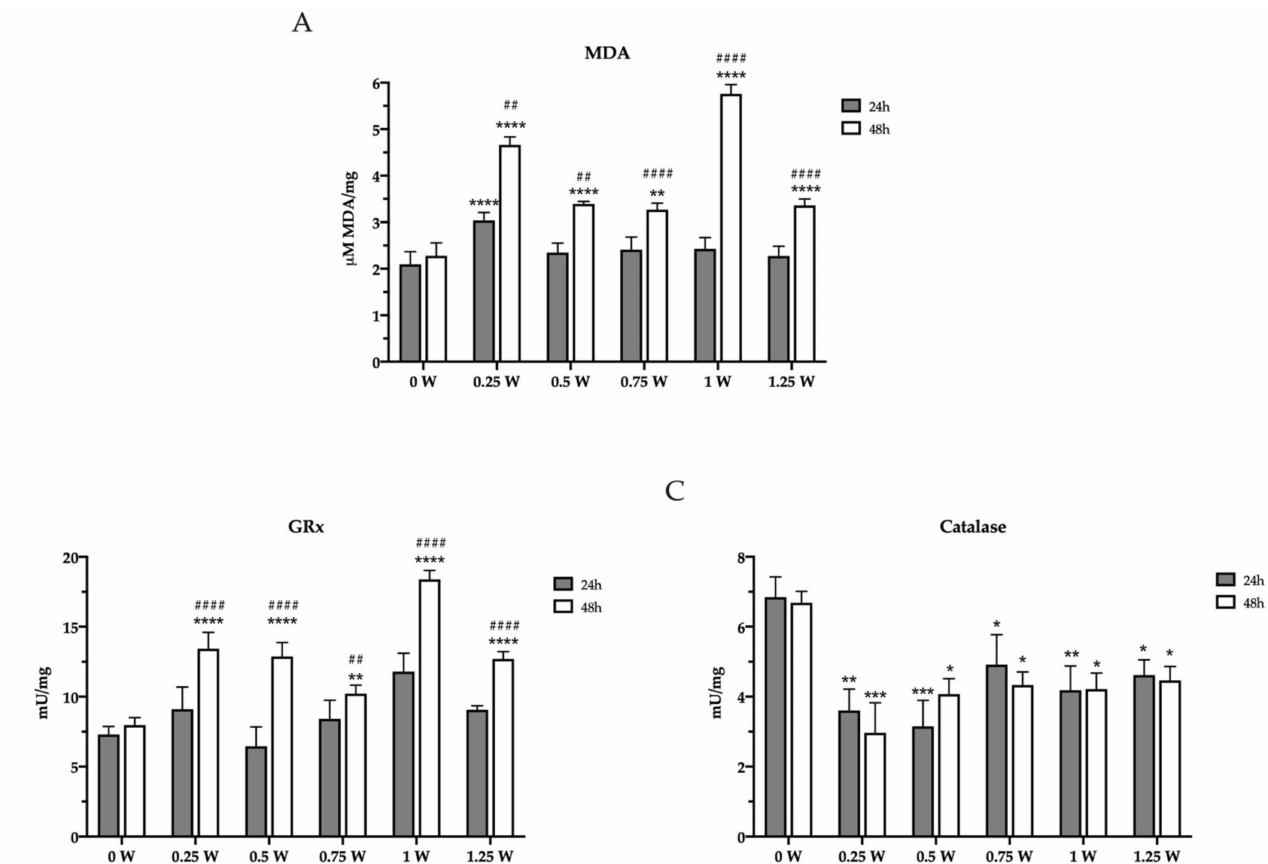
Figure 4. Lipid peroxidation and modulation of enzymatic antioxidant defenses in OHSU-974 FAcorr cells after 808-nm laser irradiation. ( A ) Malondialdheyde (MDA) level. ( B ) Glutathione reductase (GRx) activity. ( C ) Catalase activity. In each graph, grey and white columns represent the data obtained 24 or 48 h after the laser irradiation. Data are reported as mean ± SD, and each graph is representative of at least three independent experiments. Statistical significance was tested by a two-way ANOVA. *, **, *** and **** represent p < 0.05, 0.01, 0.001 and 0.0001, respectively, between the treated sample and the untreated sample (0 W) used as control, at the same time after irradiation. ## and #### represent p < 0.05, and 0.0001, respectively, between the values obtained after 24 h and 48 h from the laser irradiation in the sample treated with the same laser